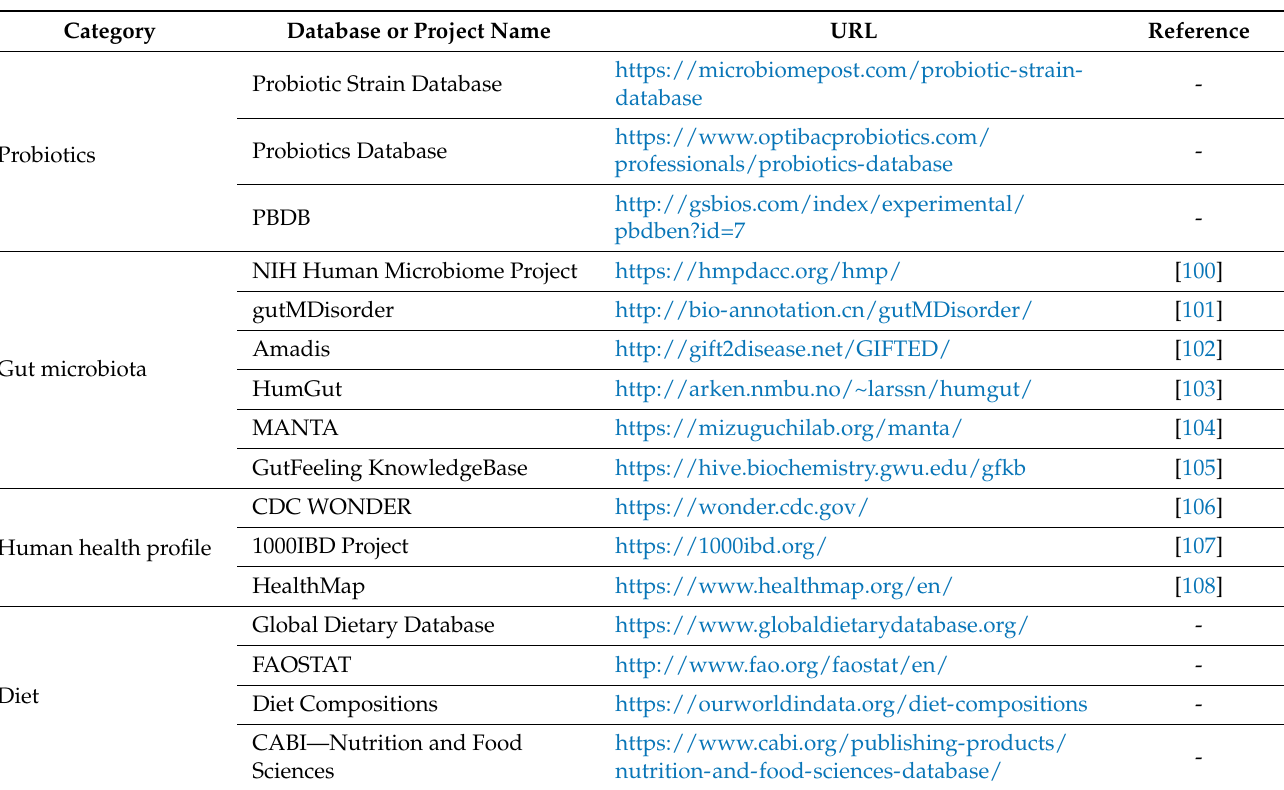
Table 2. Available data of human gut microbiota, health profile, and diet (all mentioned URLs were accessed on 28 November